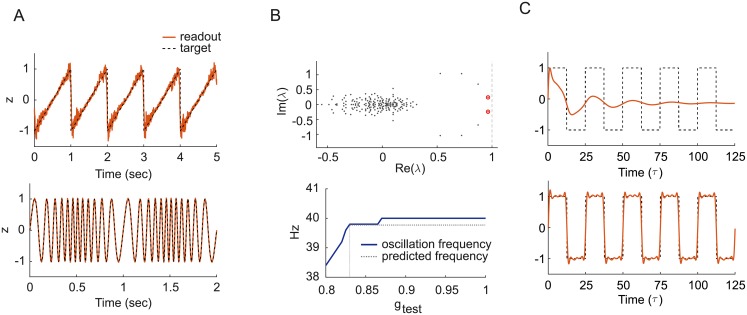
Nonlinear oscillations.A: Top: Balanced E/I spiking network of size N = 300 producing a sawtooth wave of frequency 1 Hz. Bottom: E/I rate network producing a frequency-modulated oscillation obtained by Fout(t) = sin (ω(t)t) with ω(t) linearly increasing from 2π to 6π Hz for the first half of the oscillation period, then reflected in time around the midpoint of the period. Parameters: N = 500, ϕ = halftanh, trained using feedback (Methods, ΔtL = 1 s). B: Top: Eigenvalue spectrum of Jtestϕ′|x0 for a dynamically balanced rate network with sigmoid activation function trained to produce a square wave (N = 200, output frequency f = 0.04, τ = 1), for gtest = 0.8. The two red dots indicate the two conjugate eigenvalues λ1,2 with largest real value. Bottom: Oscillation frequency as a function of gtest comparing simulation results (solid curve) with approximate prediction (dashed lines). C: Readout signal with gtest = 0.8 (top) and gtest = 1.0 (bottom).